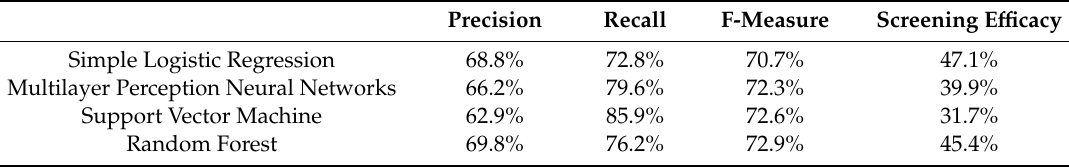
Table 5. Performance of classification models in detecting negative